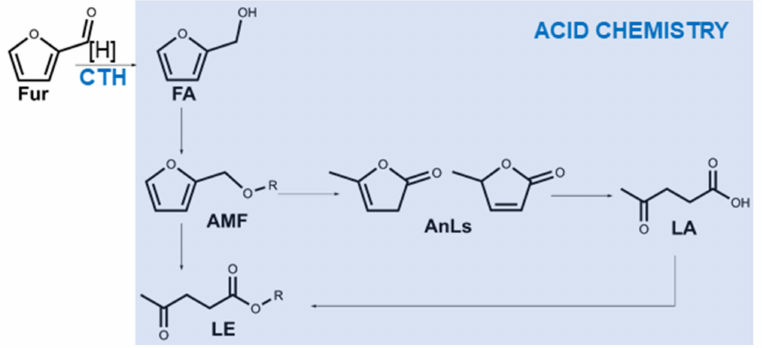
Scheme 2. Overall reaction mechanism of Fur conversion via CTH/alcohol strategies supported by the literature and the kinetic modelling studies in this work (R = alkyl